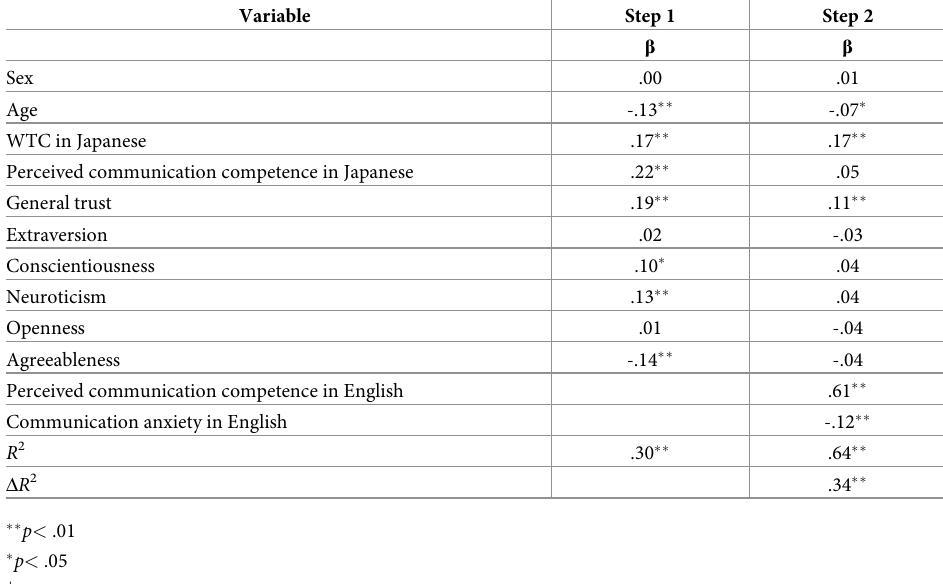
Table 2. Results of hierarchical multiple regression analysis of psychological factors on the WTC in